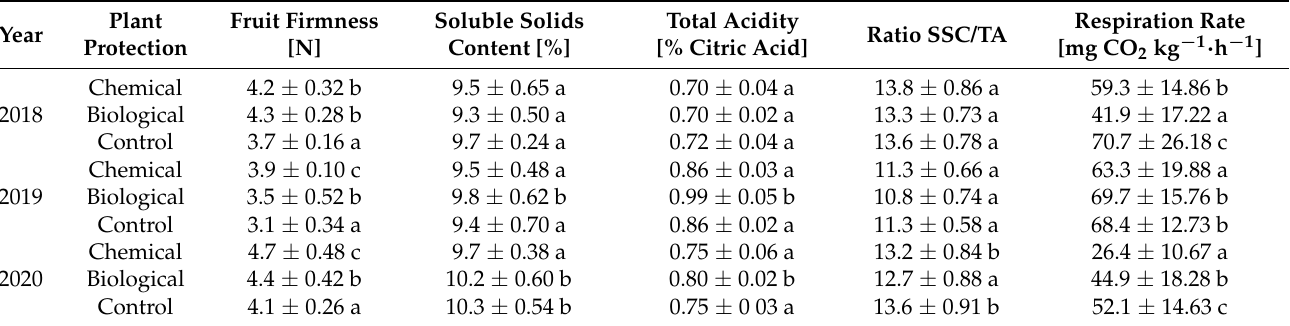
Table 6. Fruit quality of ‘Murano’ strawberry directly after harvest, average for harvest